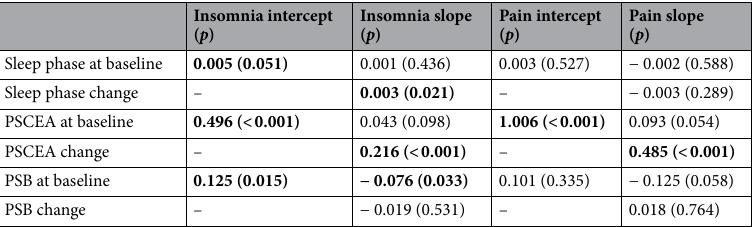
Table 5. The predictive effects of sleep-related factors on within-class change (intercept and slope factors) in pain grade and insomnia symptoms. Coefficients in bold are significant at p < 0.05 level. “Change” refers to a change score, where the value at T1 is subtracted from the value at T4. PSCEA pre-sleep cognitive-emotional arousal-causing, PSB pre-sleep